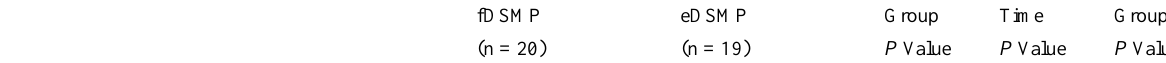
Table 3. Comparison of treatment effects: dyspnea, exercise, exercise performance, and HRQOL*